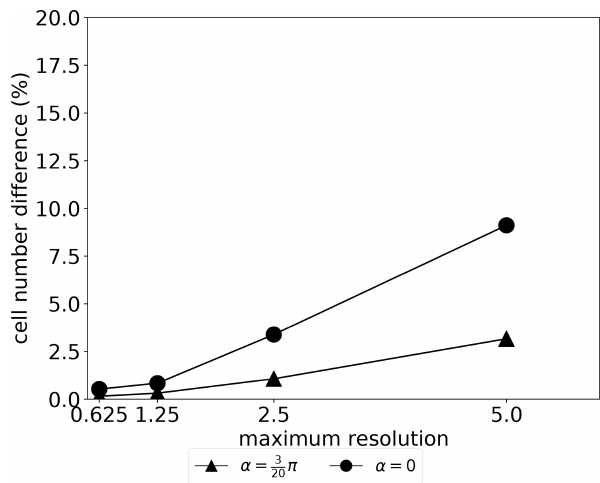
Figure 7. Percentage of cell difference of cell numbers between re- finement of intermediate steps and without intermediate steps when they use the same maximum resolution with one-level